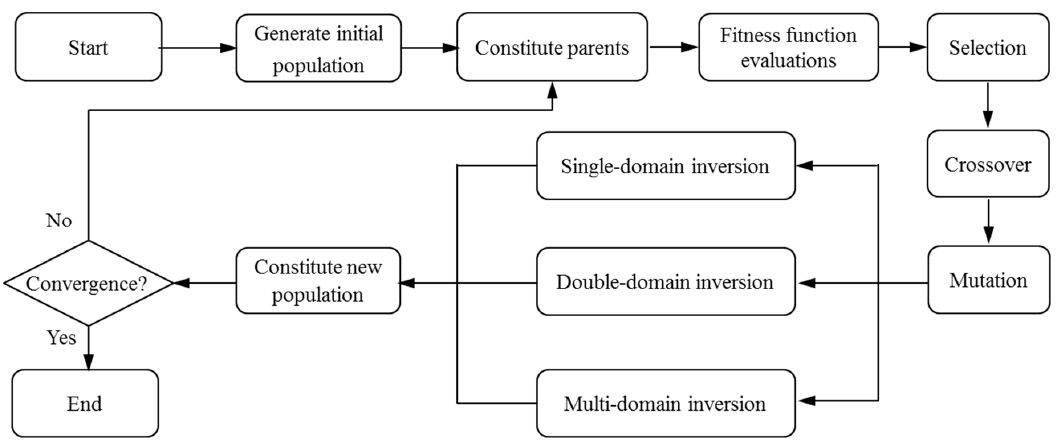
Figure 1. Flow chart of genetic algorithms.